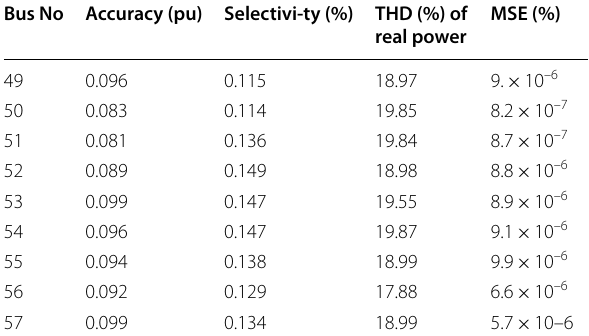
Table 5 Performance parameter analysis of standard IEEE-57 bus system using heuristic pdf